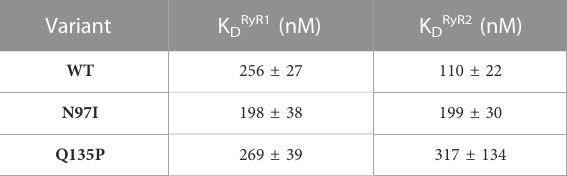
TABLE 1 Apparent af fi nities of CaM-RyR1/2 complexes assessed by fl uorescence spectroscopy.